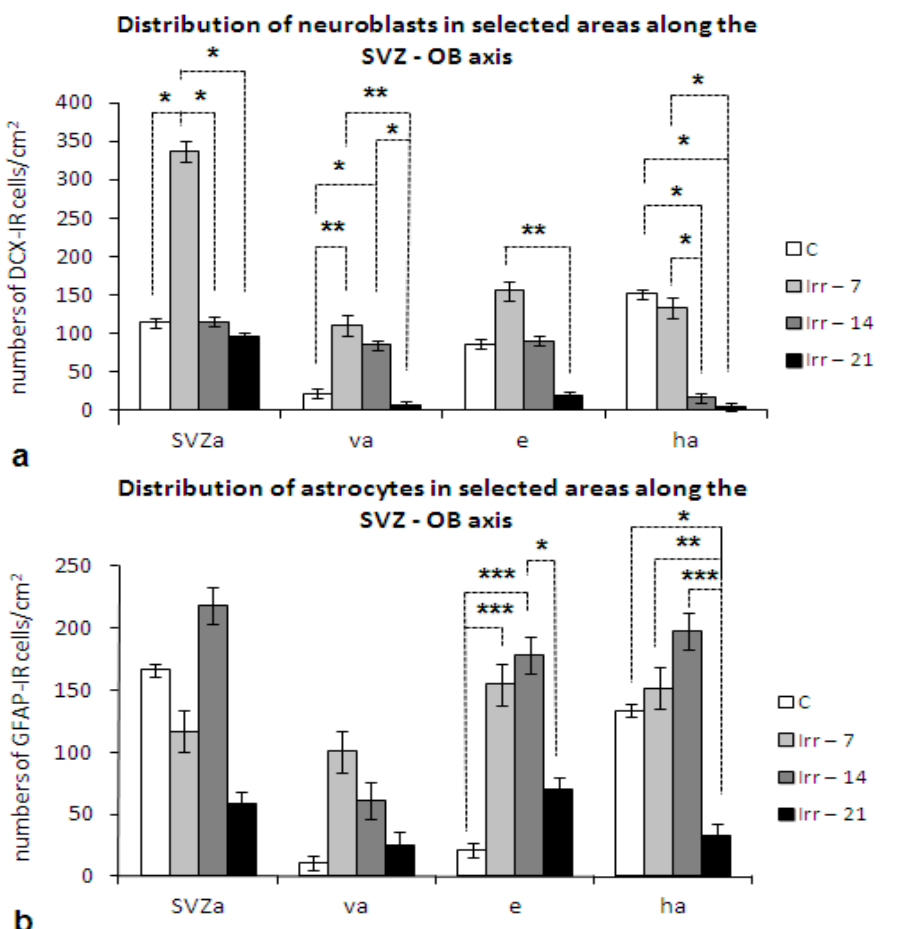
Figure 2. Distribution of ( a ) DCX immunoreactive (DCX-IR) and ( b ) GFAP (glial fibrillary acidic protein) immunoreactive (GFAP-IR) cells in the anterior horn of the subvetricular zone (SVZa), vertical arm (va), elbow (e), and horizontal arm (ha) in the RMS of control and irradiated adult male rats investigated at 7, 14 and 21 days after fractionated irradiation with a total dose of 3 Gy (C, Irr-7, Irr-14, Irr-21; x ± SEM). Statistical significance of differences between control and irradiated group and between the irradiated animals: * p ≤ 0.05; ** p ≤ 0.01; *** p ≤ 0.001.